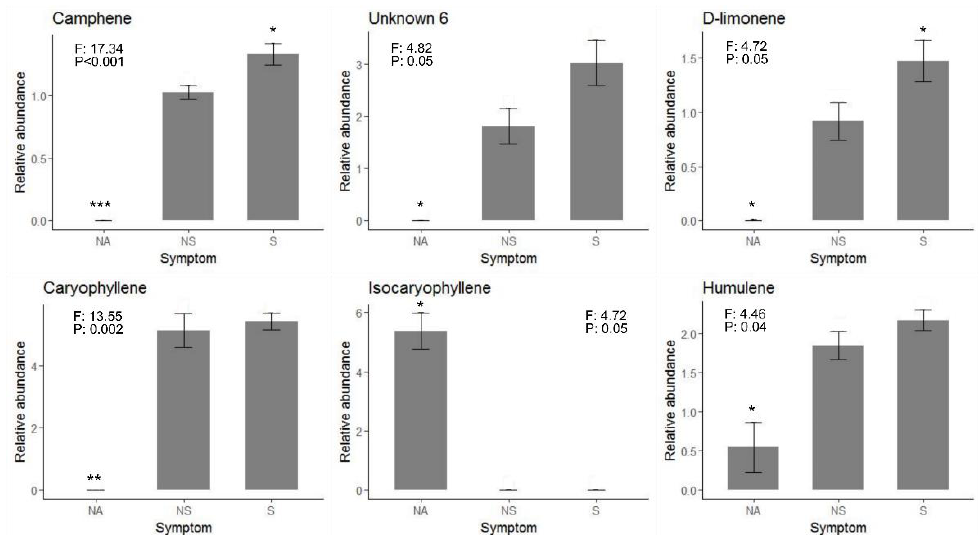
Figure 3. Relative abundance (%) of the six main secondary compounds for disease degrees (NA: non-symptomatic pines in healthy stands, NS: non-symptomatic pines within declining stands, S: symptomatic pines within declining stands). Data are mean ± SE of n = 5 pines per degree of disease. Asterisks represent differences between disease degrees: p < 0.001 (***), p < 0.01 (**) and p < 0.05 (*). 3.3. Morphological Traits